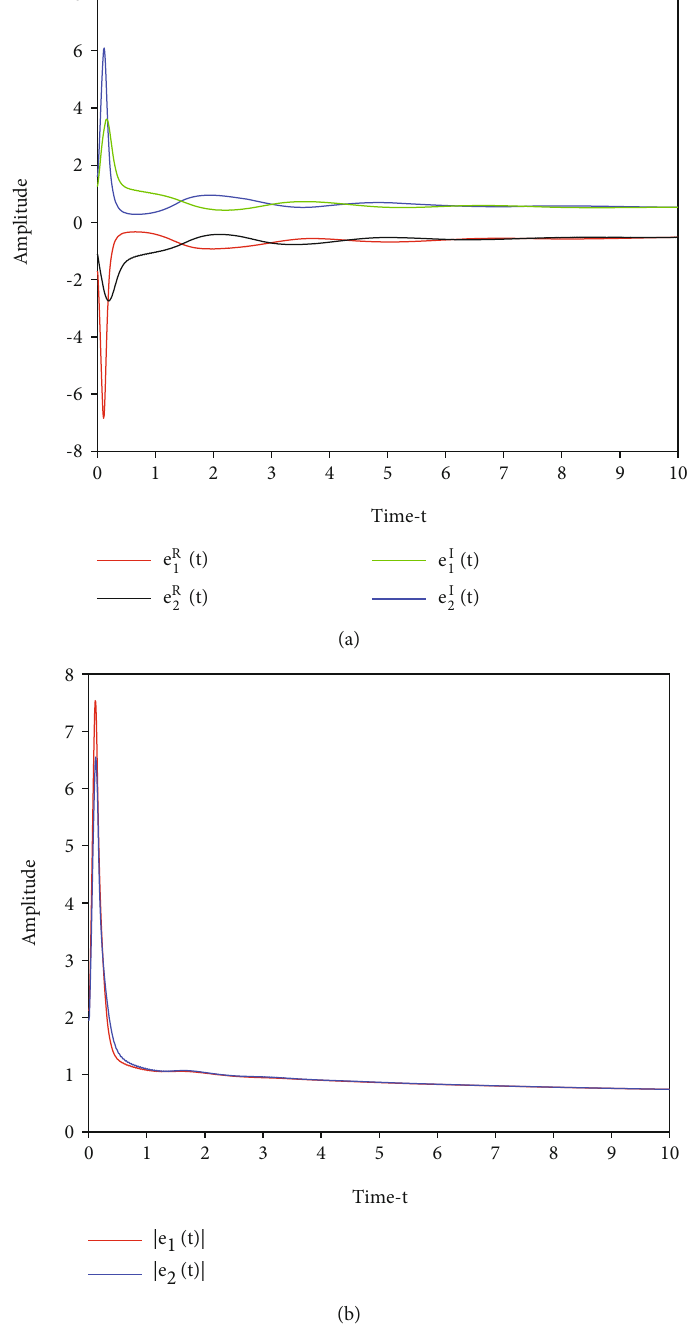
Figure 4: The error trajectories of FCVCGNNs without the controller. (a) The curves of real parts and imaginary parts. (b) The curves of modulus of